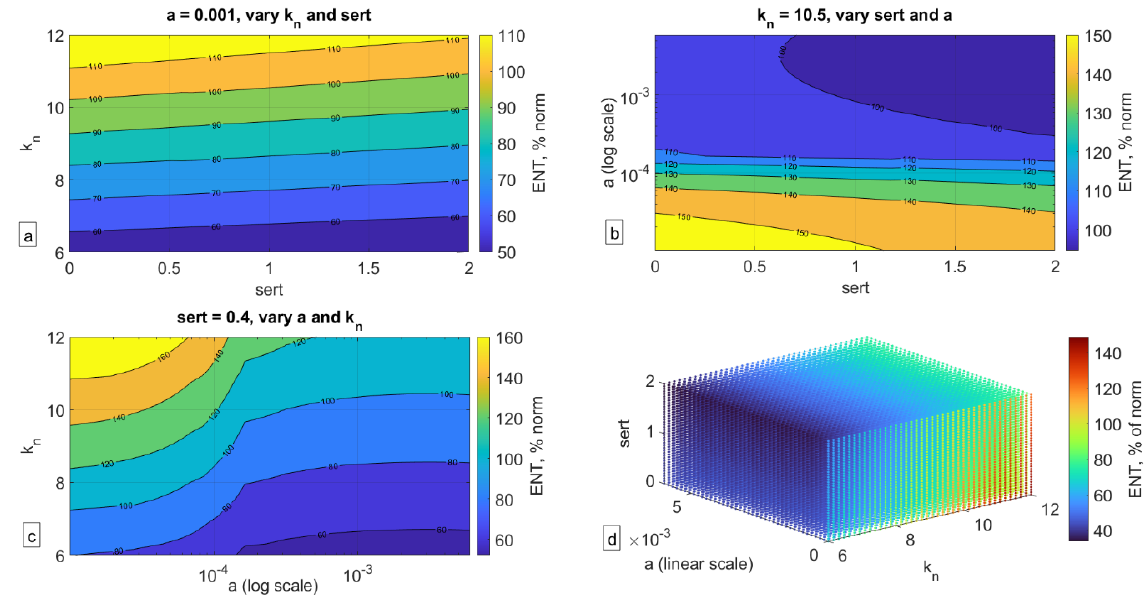
Figure 5. Impact of variation of the three key parameters on ENS size relative to norm (ENS = 100%) at t = 5 years. ( a ) Holding parameter a (serotonin synthesis) constant, ( b ) holding parameter k n (serotonin-mediated ENS expansion) constant, ( c ) holding parameter sert (SERT-mediated serotonin uptake) constant, ( d ) three-dimensional plot of variation of all three parameters and their impact on ENS size.